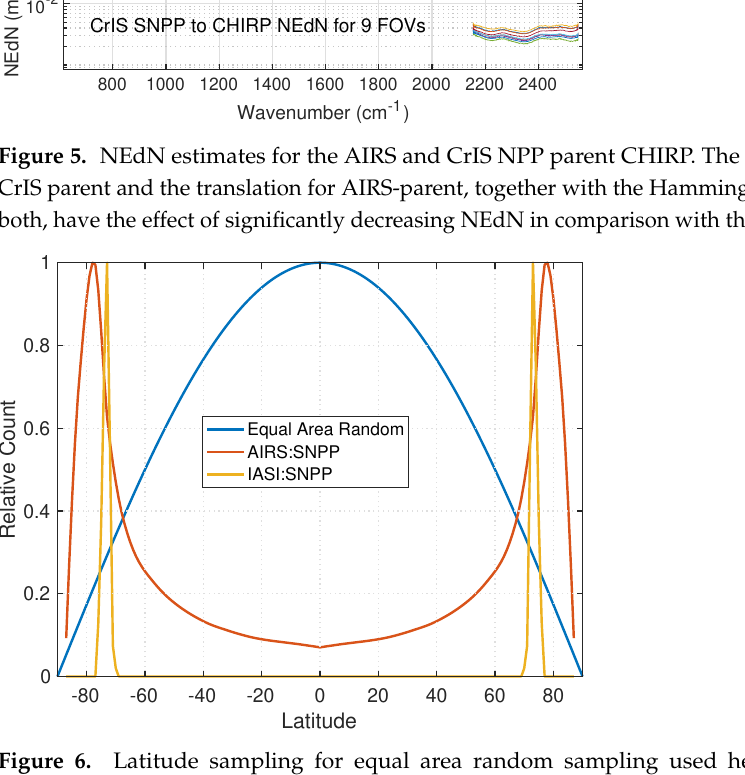
Figure 6. Latitude sampling for equal area random sampling used here for statistical inter- comparisons, SNO pairs between AIRS and SNPP, and SNO pairs between IASI and